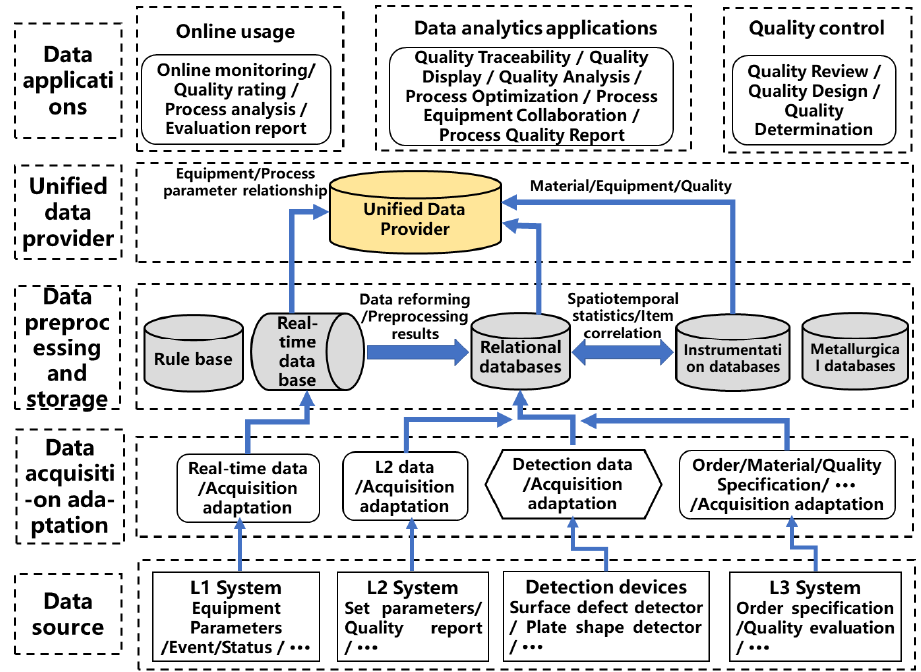
Figure 4. Architecture for quality control technologies in steel industry.